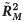
ACME and ADE graphical plots for some exemplary regulatory loops at 24h IR.A dashboard showing graphical plots associated with two types of loops at 24h of IR, partial mediation and complete mediation loop respectively. Each row displays three plots. The left plot shows the average causal mediation effect ACME, average direct effect ADE, and total effect for the particular type of loop on right margin of the plots. The dashed horizontal line represents the estimated mediation effect under the sequential ignorability assumption. The middle and right plots are the sensitivity analysis plots as a function of the standard deviation of the ACME ρ and the mean square error R2 respectively. R˜M2 is the square of the correlation between independent variables(M→X), while R˜Y2 is the square of the correlation between dependent and independent variables(Y→X,M).